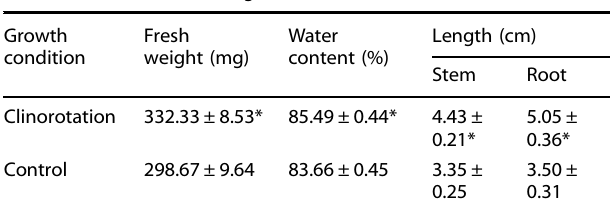
Table 1. Growth of seedlings ( n = 30).